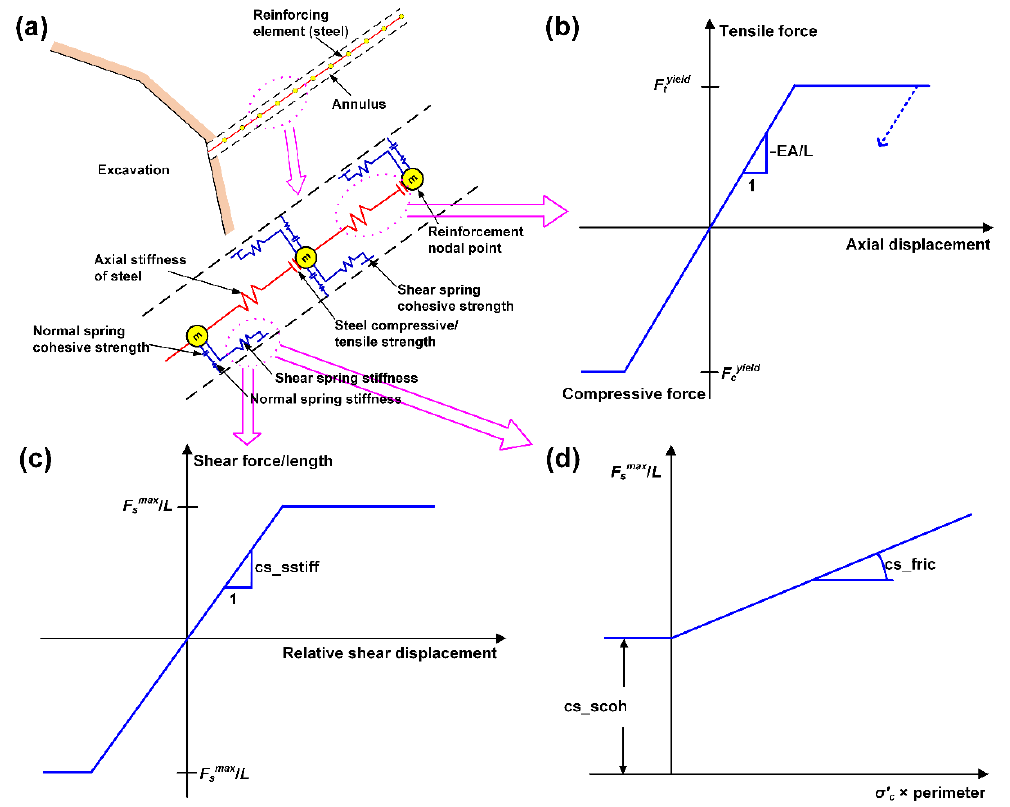
Figure 10. ( a ) Conceptual mechanical representation of the “rockbolt” element, which accounts for shear behavior of grout annulus and bending resistance of the reinforcement. ( b ) Mechanical behavior of the “rockbolt” element in the axial direction. ( c ) Shear force versus displacement of the shear coupling spring. ( d ) Shear criterion of the shear coupling spring (( a ) is modified after Itasca [62]; ( b – d ) are from Itasca